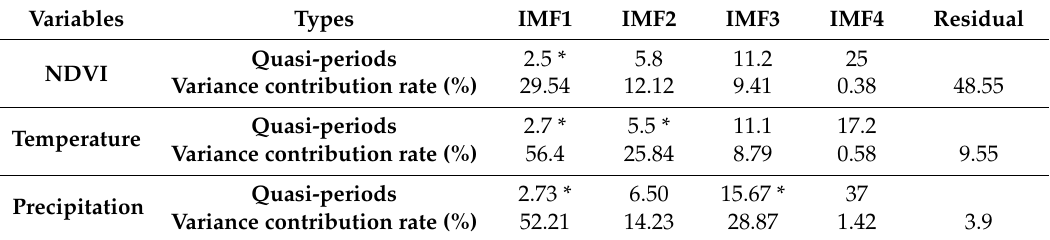
Figure 6. EEMD decomposition for ( a ) Average temporal changes in the growing-season NDVI, ( b ) temperature, and ( c ) precipitation during 1982–2015 in the karst region of Southwest China. IMF1-IMF4 components and residual represent di ff erent time scales and long term trend, respectively. Table 1. Average quasi-periods and their variance contributions to NDVI, temperature and precipitation changes at di ff erent time scales (IMF1–IMF4) and residuals of all pixels in the karst region of southwest